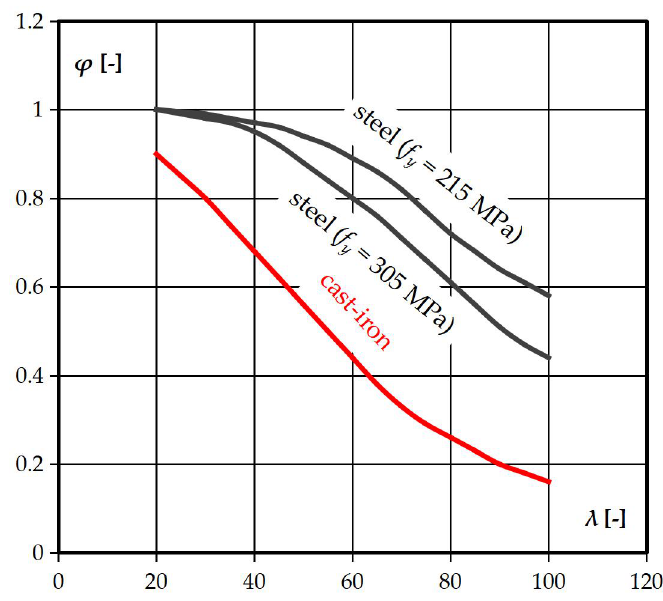
ffi cient ϕ as a function of column slenderness λ Figure 3. Overall instability coefficient φ as a function of column slenderness λ. Figure 3. Overall instability coe